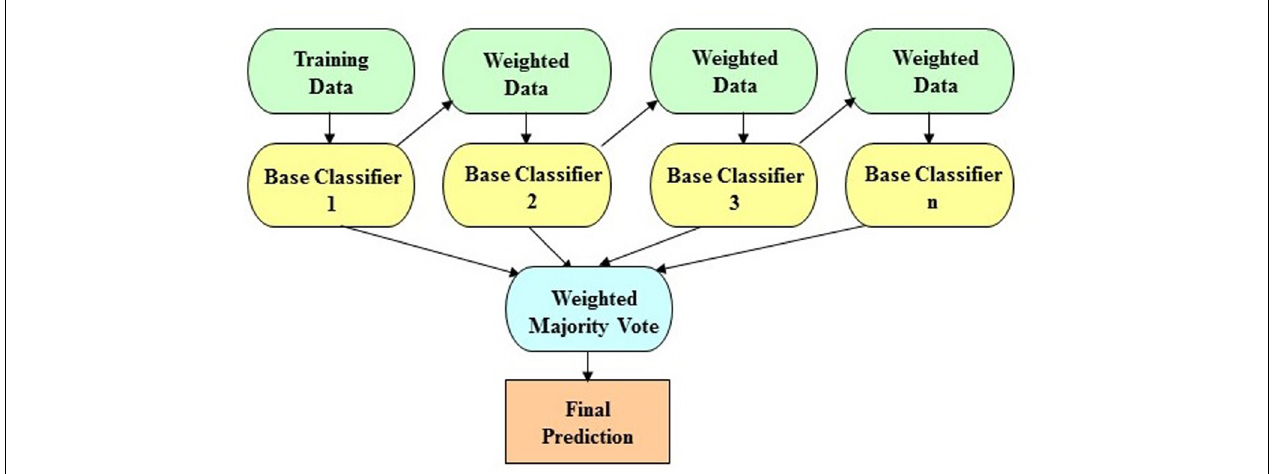
FIGURE 1 | The schematic illustration of the ensemble boosting method. The idea of the ensemble boosting approach is to train weak/base classifiers sequentially in a way that each classifier tries to correct its predecessor. A higher weight is assigned to samples that were incorrectly classified by earlier rounds. That is, week/base classifiers are produced in sequence based on a weighted version of the data during the training phase. The final classification prediction is then produced by a weighted majority vote.